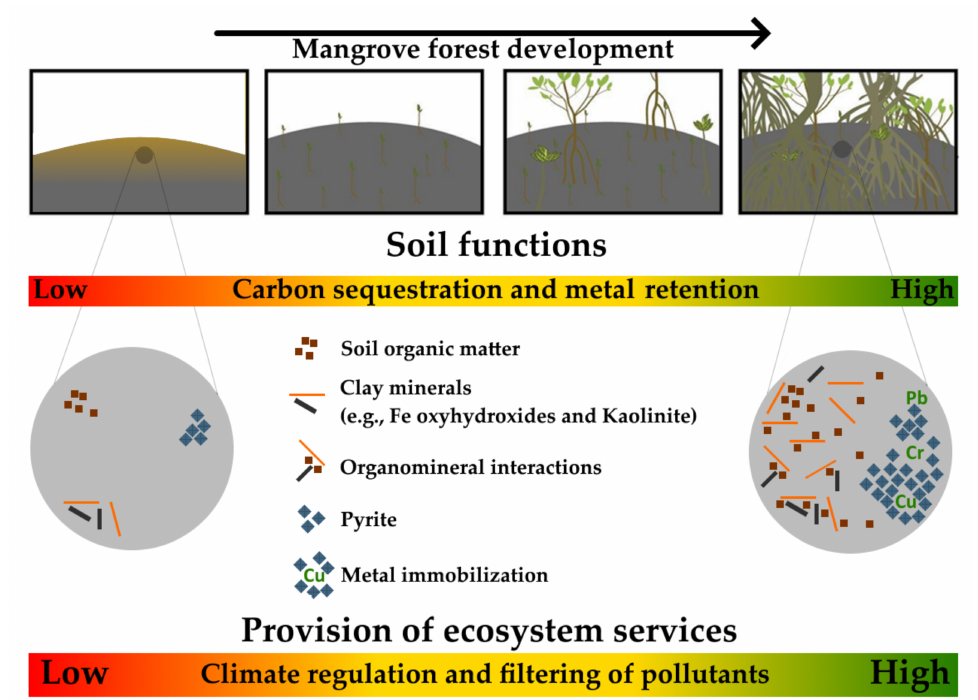
Figure 10. Schematic summary showing a conceptual model for the recovery of the studied soil functions upon mangrove revegetation. The development of mangrove forests led to an increase in organic matter input from vegetation and fine particle trapping (e.g., phyllosilicates and Fe oxyhydroxides), which contributed to increasing SCS. An increase in reactive Fe favors pyritization and, thus, the potential for pollutant immobilization. The recovery of these soil functions shows high potential for restoring the ecosystem services of climate regulation and filtering of